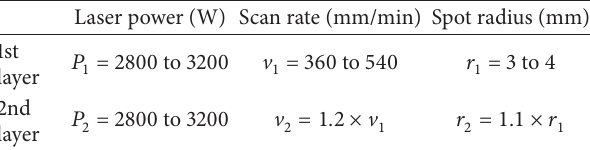
Figure 2: Laser repairing equipment. Table 1: Laser repairing processing